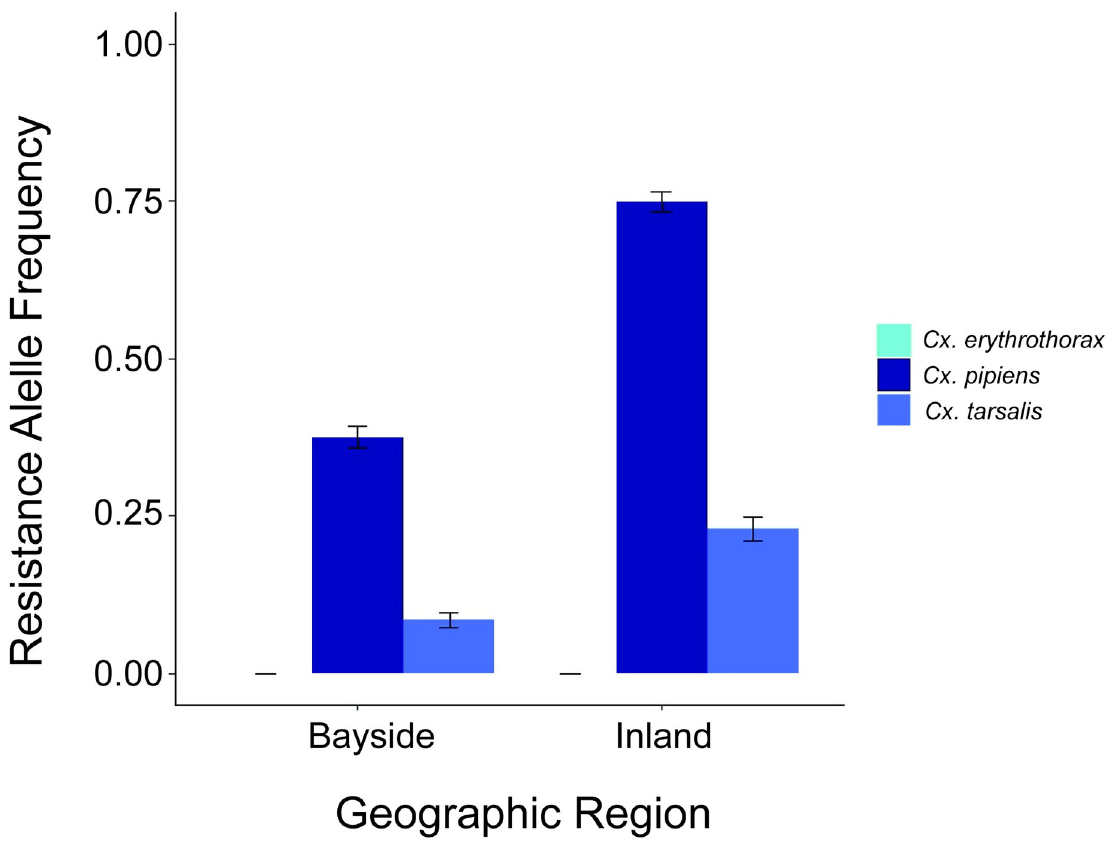
Fig 7. Resistant allele frequency (F (FF,LF) ) of the L1014F kdr mutation by species and region. Bright blue, dark blue and medium blue bars represent F (FF,LF) for Cx . erythrothorax , Cx . pipiens and Cx . tarsalis , respectively. The F (FF,LF) for bayside Cx . pipiens and Cx . tarsalis was 0.375 ± 0.018 and 0.0840 ± 0.012, respectively. The F (FF,LF) for inland Cx pipiens and Cx . tarsalis was 0.749 ± 0.016 and 0.230 ± 0.016,